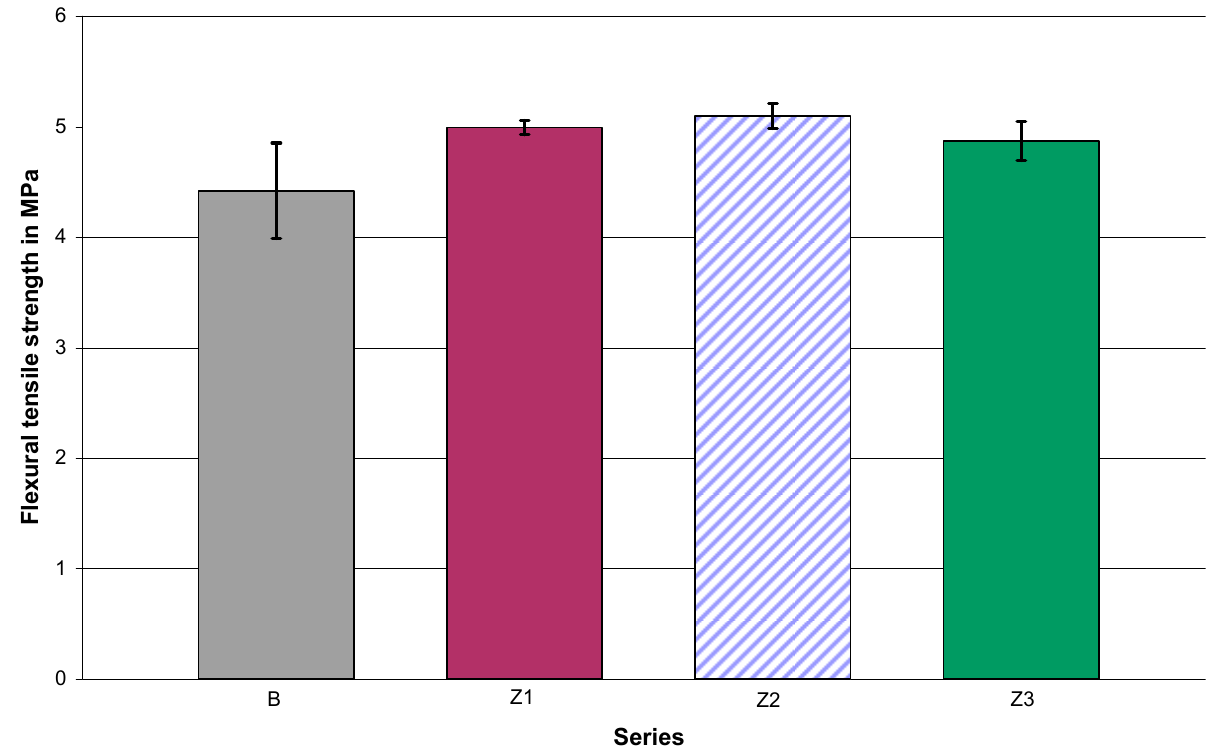
Figure 8. Results of the flexural tensile strength test for the concrete without the scattered reinforcement and the concrete with the scattered reinforcement in the form of PET fibres.